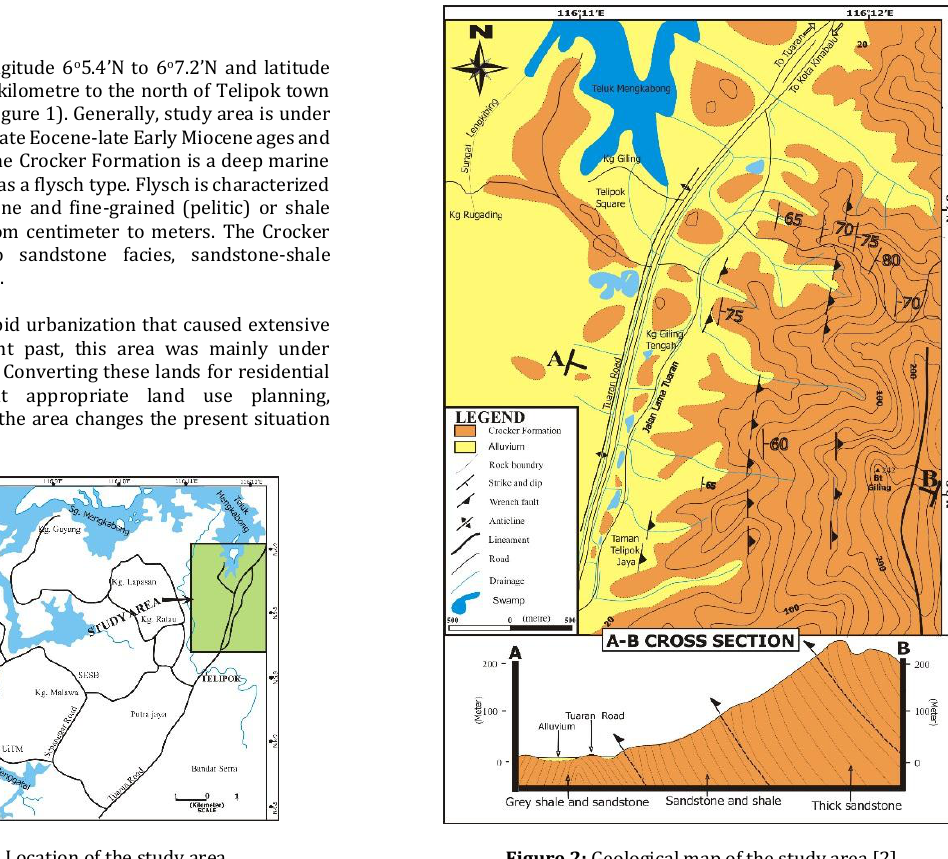
Figure 1: Location of the study area Figure 2: Geological map of the study area